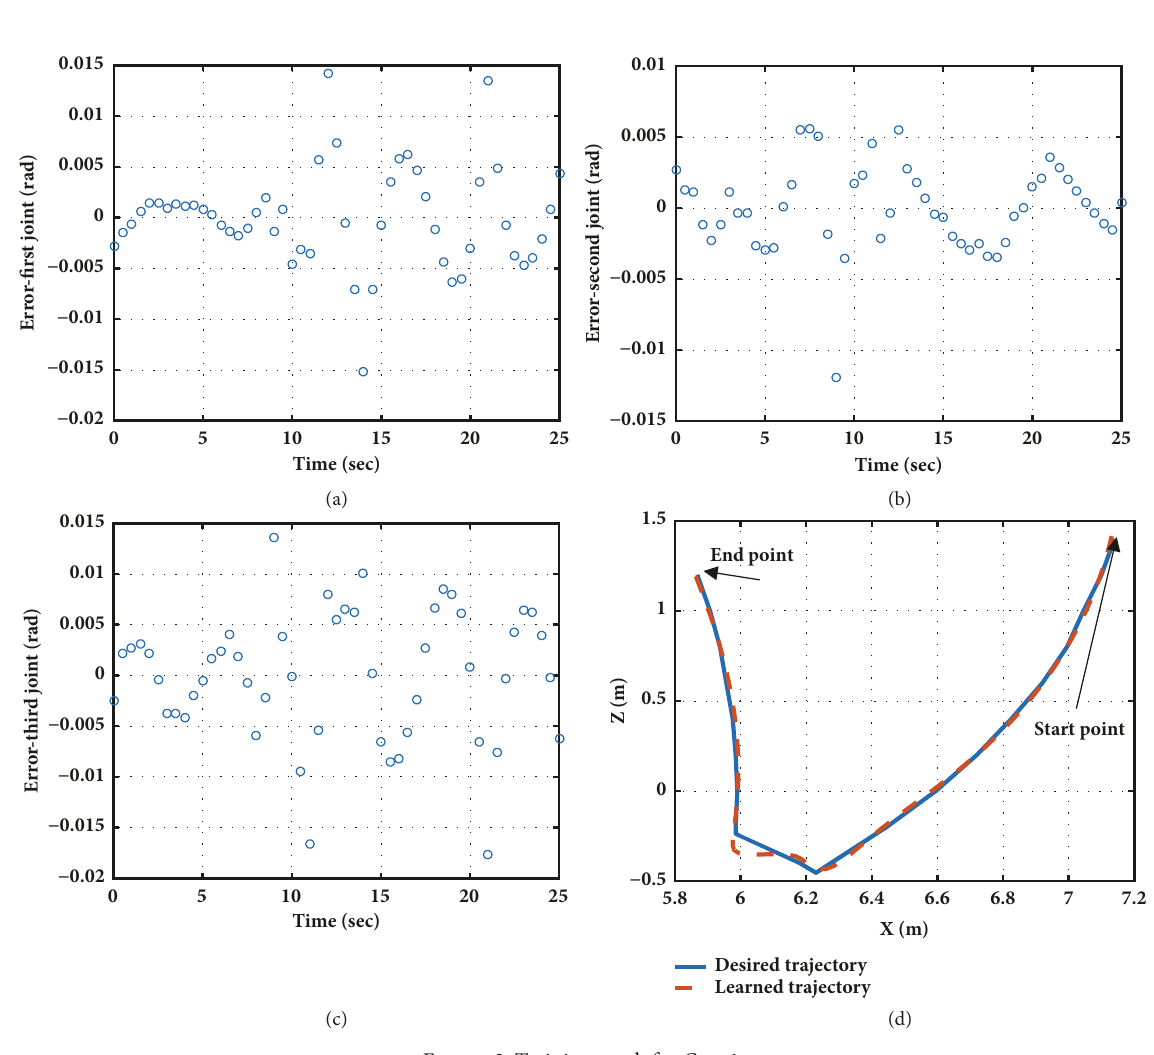
Figure 3: Training result for Case